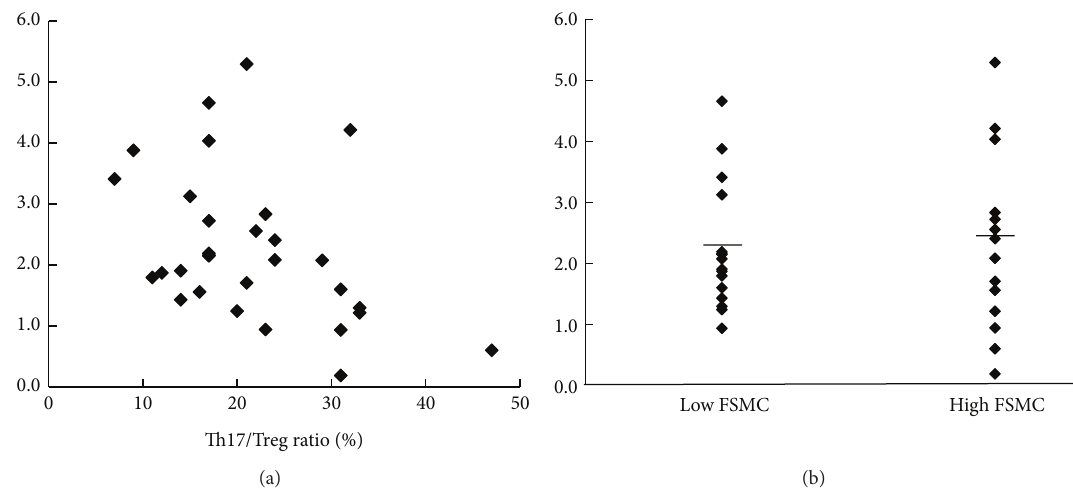
Figure3:CorrelationofIL-10withT17/Tregratio.(a)ScatterplotofcorrelationbetweenTh17/TregratioandLNIL-10( 𝑟 = −0.408 , 𝑝 = 0.025 ). (b) Levels of LN IL-10 in low and high FSMC groups. Bars represent the mean of LN IL-10.